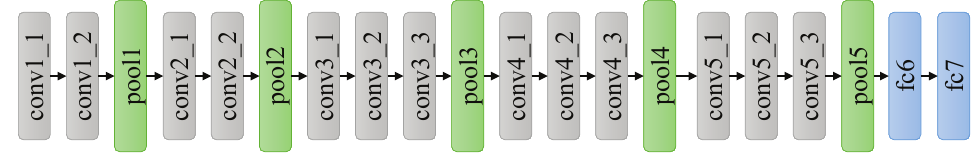
Figure 5. The architecture of